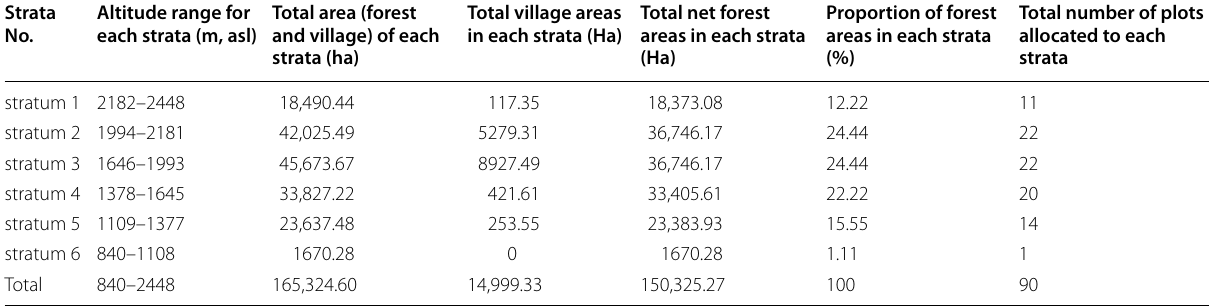
Table 1 Stratification of the study area and total number of plots allocated to each stratum Strata No.